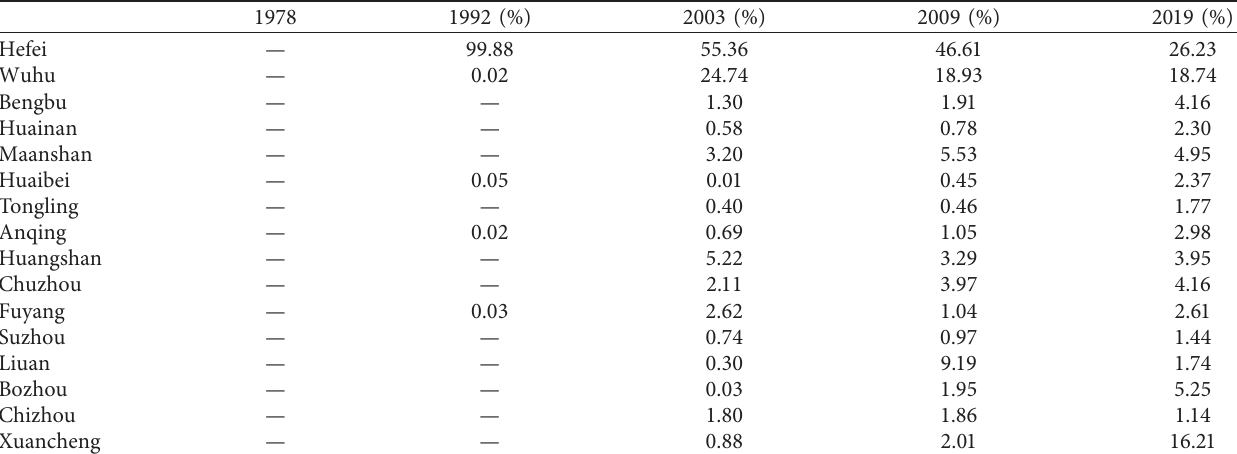
Table 7: Proportion of enterprise investment in cities in Anhui